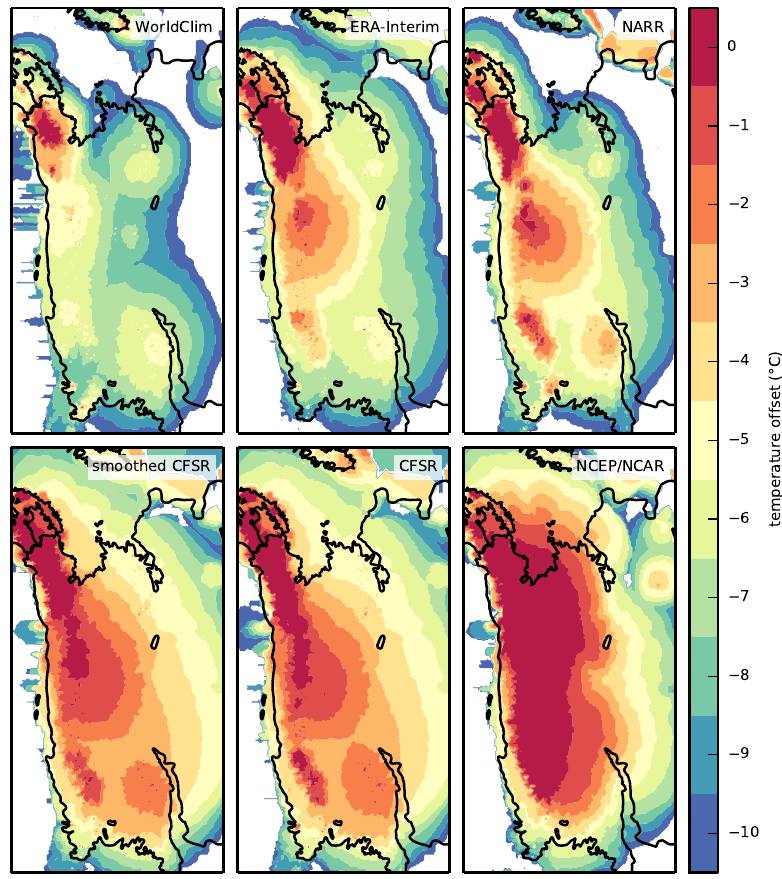
Figure 6. Extent of ice cover after 10kyr as a function of applied temperature offsets for each climate forcing used. A reconstructed LGM ice sheet margin by Dyke (2004) (Fig. 1) is given for reference (black